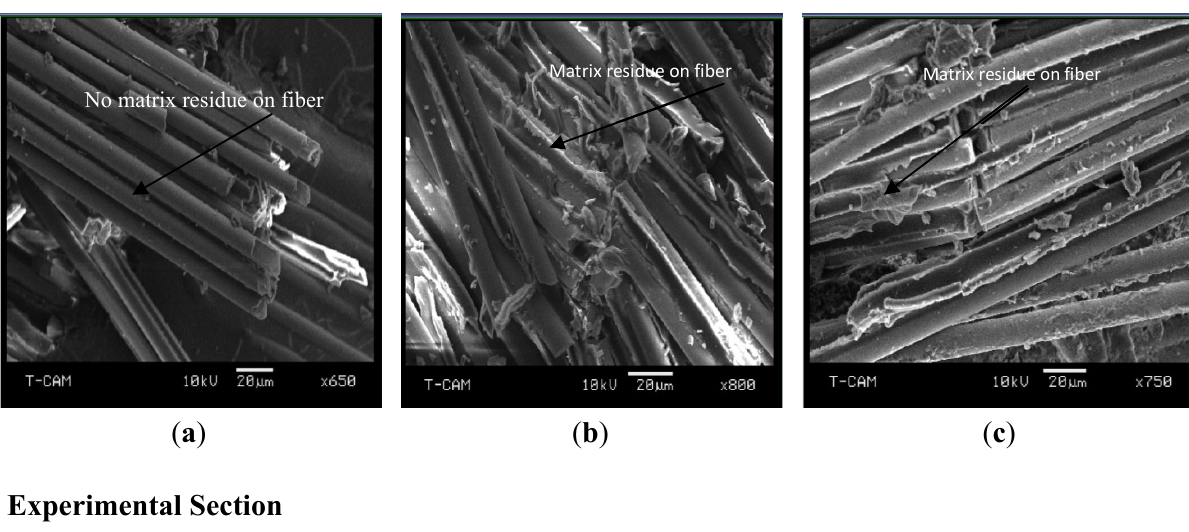
Figure 4. SEM micrographs of factured surface for the nanocomposite laminates ( a ) Neat E-glass/epoxy; ( b ) 2 wt.% magnetic + 3 roll milling; ( c ) 3 wt.% Sonication + 3 roll